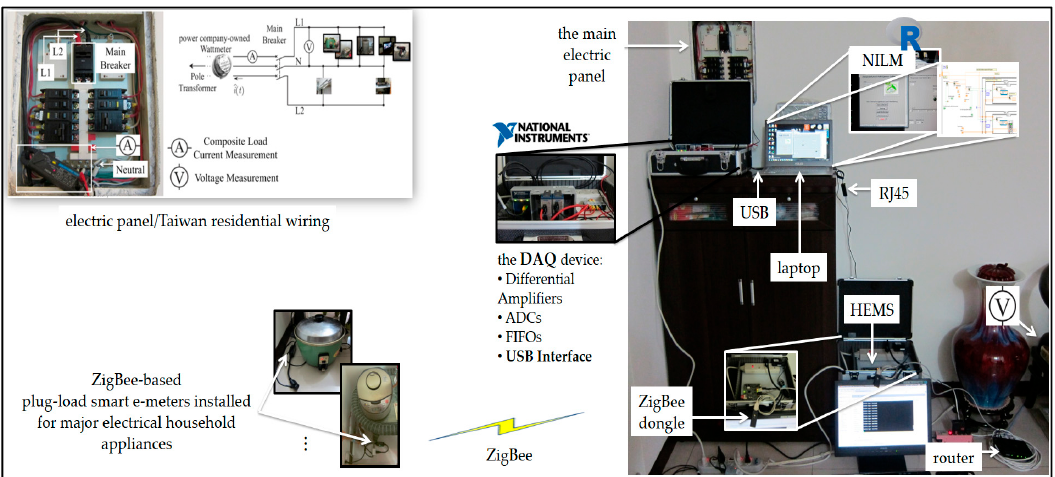
Figure 7. Experimental setup of the HEMS with the NILM proposed in this paper, deployed and experimentally evaluated in a realistic house environment in Taiwan. The HEMS, taken as a benchmark with the installed ZigBee-based smart e-meters, was compared. For the NILM, only one single minimal set of current and voltage sensors needed to be installed.